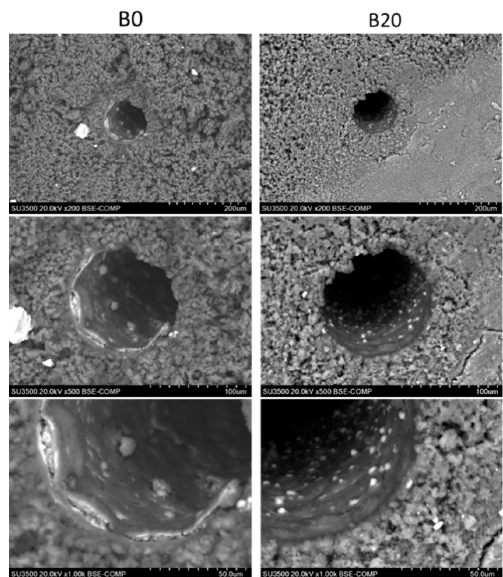
Figure 9. Injector hole deposits for B0 and B20.